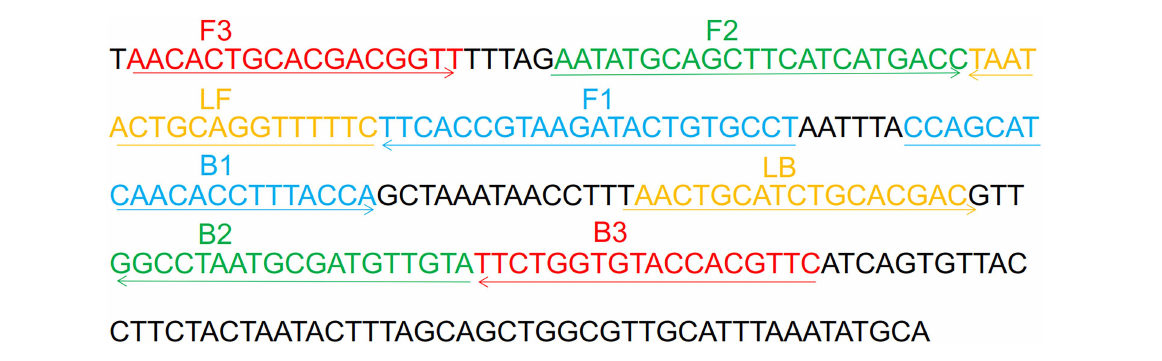
FIGURE 1 Sequence and location of OMP P6 gene used to design Haemophilus influenzae -ERT-LAMP primers. The nucleotide sequences of the sense strand of OMP P6 are listed. Right arrows and left arrows indicate sense and complementary sequences that are used.